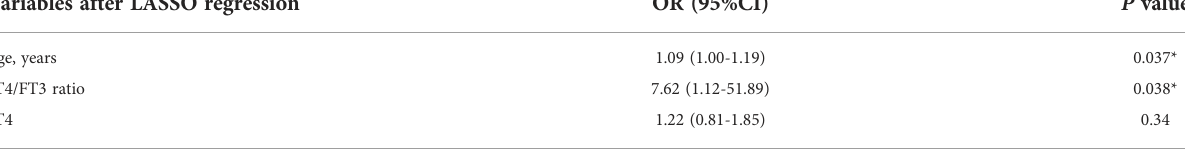
TABLE 3 Multivariate Logistic regression analysis for predicting